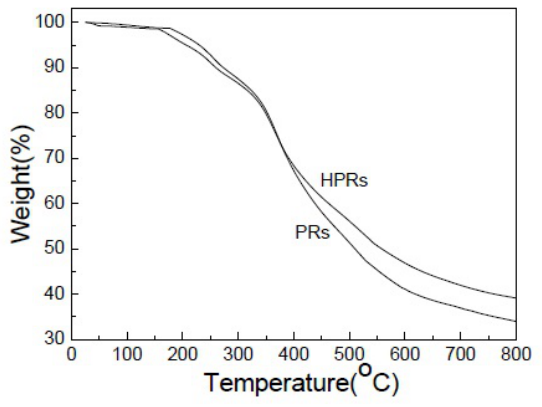
Figure 3: The TGA curves of PRs and HPRs